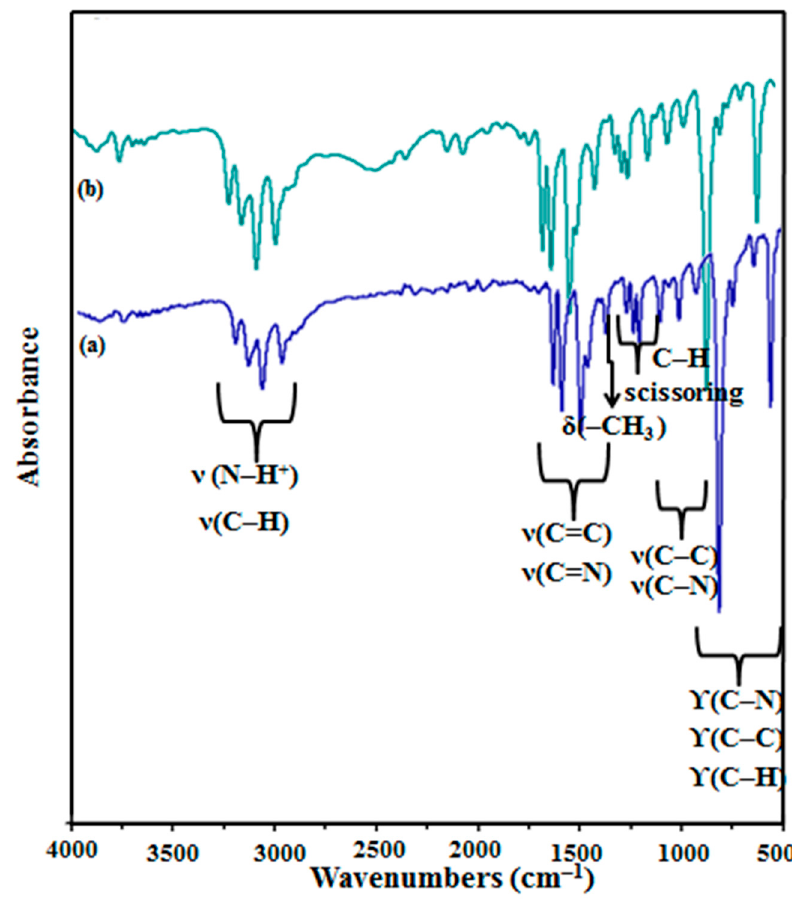
Figure 8. The experimental IR absorption spectra of compounds ( I ) ( a ) and ( II ) ( b ).